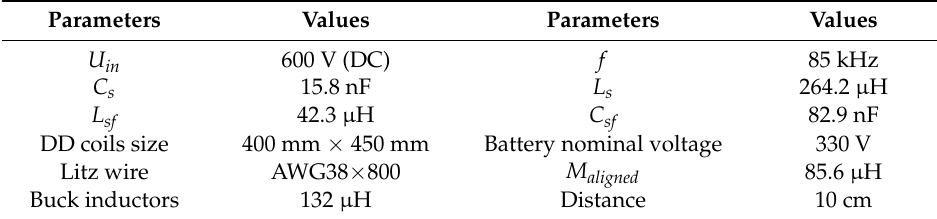
Table 3. Components’ parameters of the three primary LCC resonant networks.